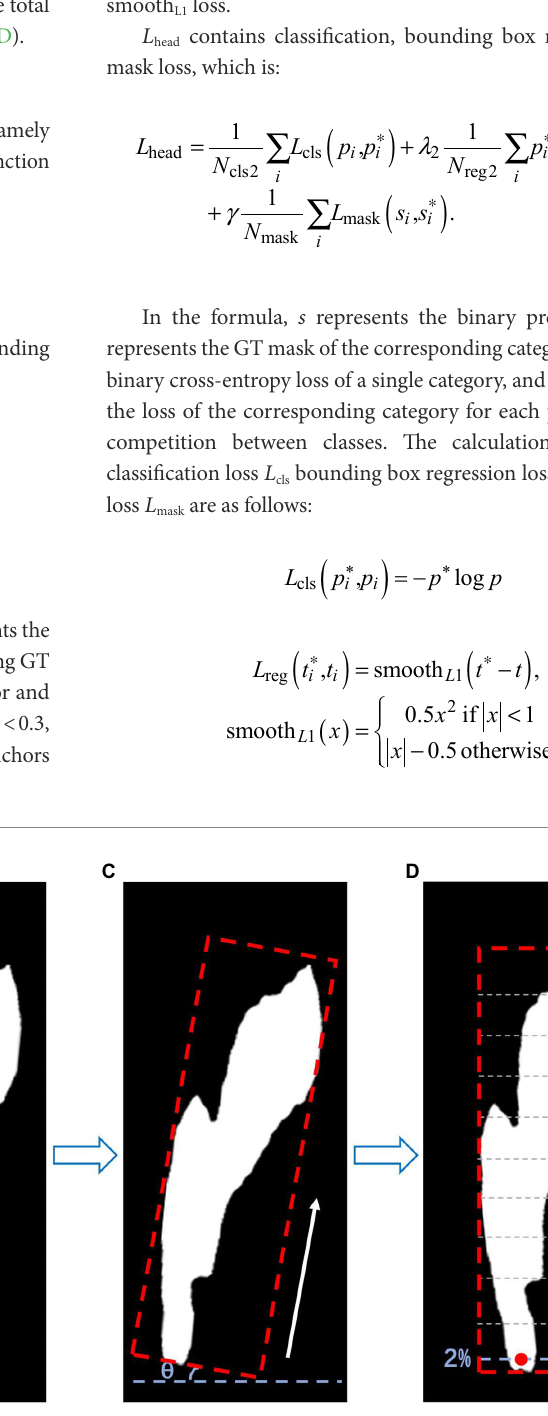
FIGURE 4 Implementation of picking point determination (A) the result of the contour of shoot identification, (B) the determination of the shoot main mask, (C) calculation of the minimum circumscribed rectangle, and (D) calculation of the 2D coordinate information of the picking